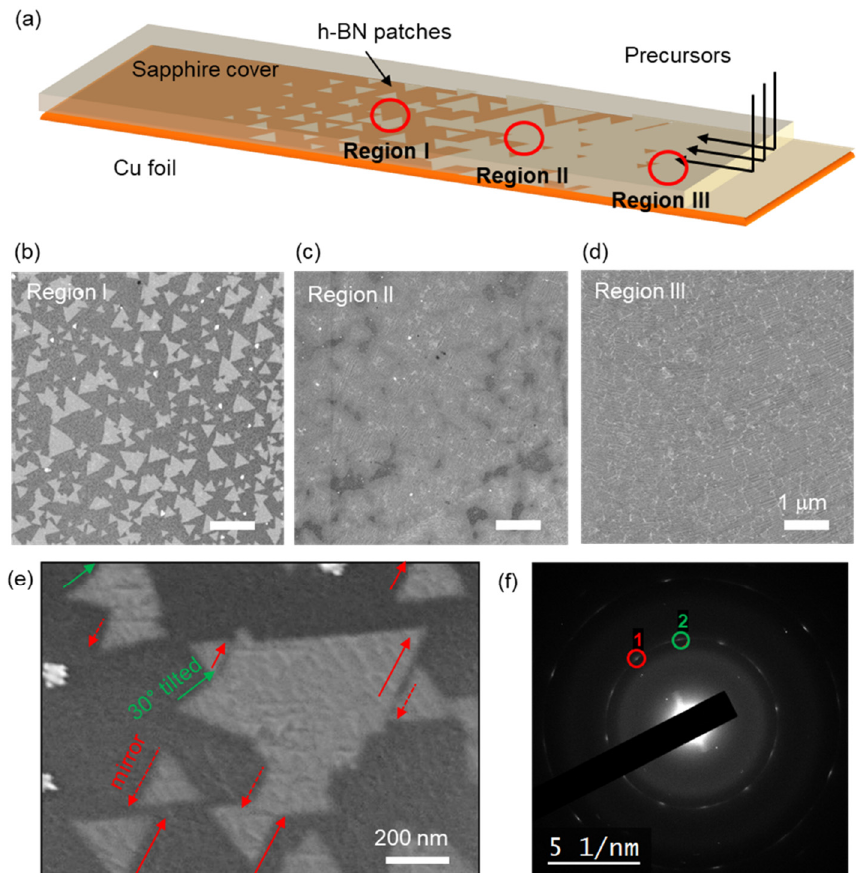
Figure 4. Observation of triangular patches of h-BN grown under minimized feeding rate using sapphire wafer as a cover. ( a ) Illustration of the experimental set-up and growth behavior of h-BN microdomains on Cu foil. ( b – d ) FE-SEM images taken from different location of the region under the sapphire cover. ( b ), ( c ), and ( d ) correspond to the regions I, II, and III marked by red circles in ( a ), respectively. Alignment of the crystal orientations of h-BN triangular nanopatches. ( e ) FE-SEM image of h-BN nanopatches synthesized on Cu foil. Most h-BN patches were aligned to a single direction (red arrows), or its mirror (red-dashed arrows), or tilted by 30° (green arrows). ( f ) Typical SAED pattern of the synthesized h-BN film. Two major domain orientations separated by 30° are marked as 1 and 2, respectively.